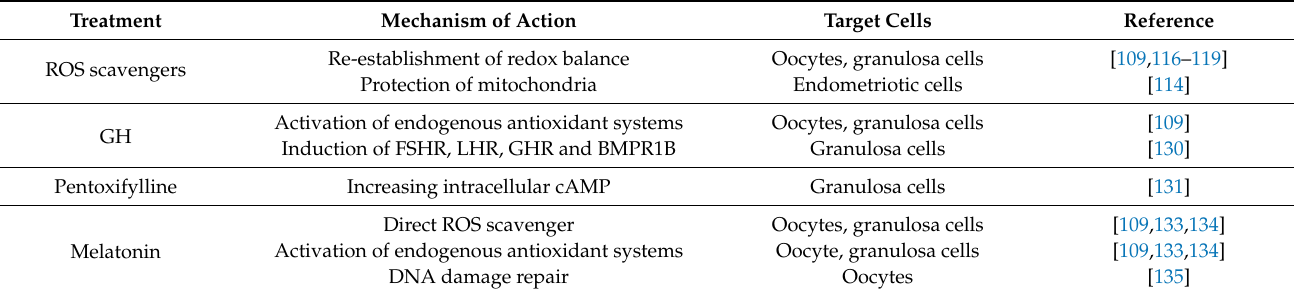
Table 1. Treatments that improve female fertility and their tentative mechanisms of action